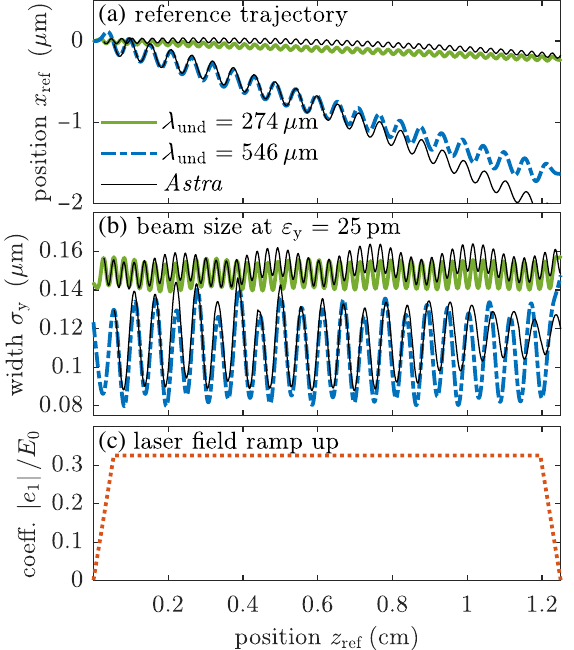
FIG. 13. DLA track6 D simulations of the reference trajectory in (a) and transverse rms. size in (b) of an electron beam with ε 25 pm and ε ε 0 emittance for two operation modes of the x ¼ z ¼ asynchronous DLA undulator with linear laser field ramp-up shown in (c). The ASTRA [43] simulations show the results of a fully numeric, time-dependent beam dynamics model calculated with particle tracking in a 3D field map of the DLA cell from CST STUDIO